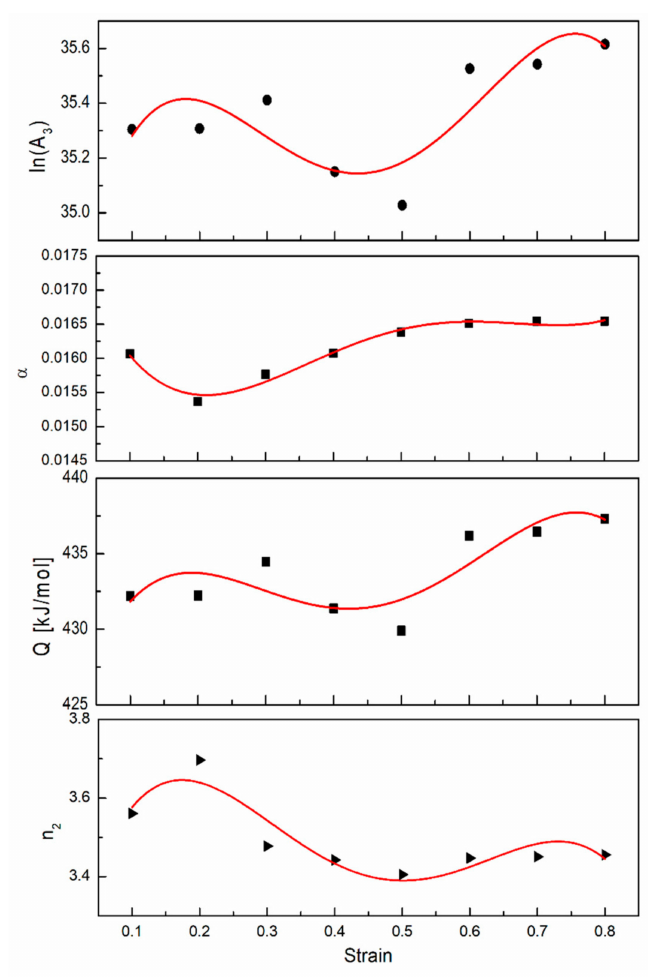
Figure 5. The fits of the dependence of ln(A 3 ), α , Q 3 , and n 2 on true strain by a fourth-order